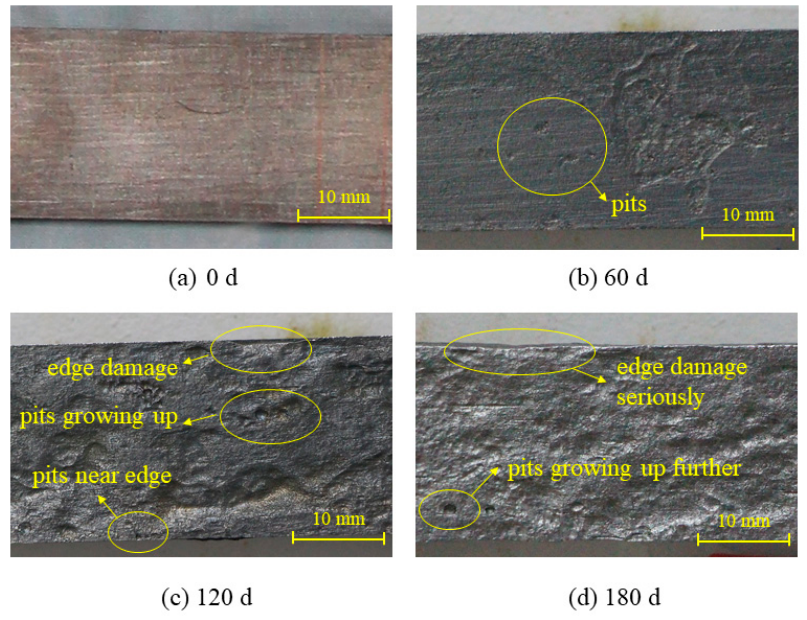
Figure 5. Corrosion morphologies: ( a ) rust 0 days; ( b ) rust 60 days; ( c ) rust 120 days; ( d ) rust 180 days.